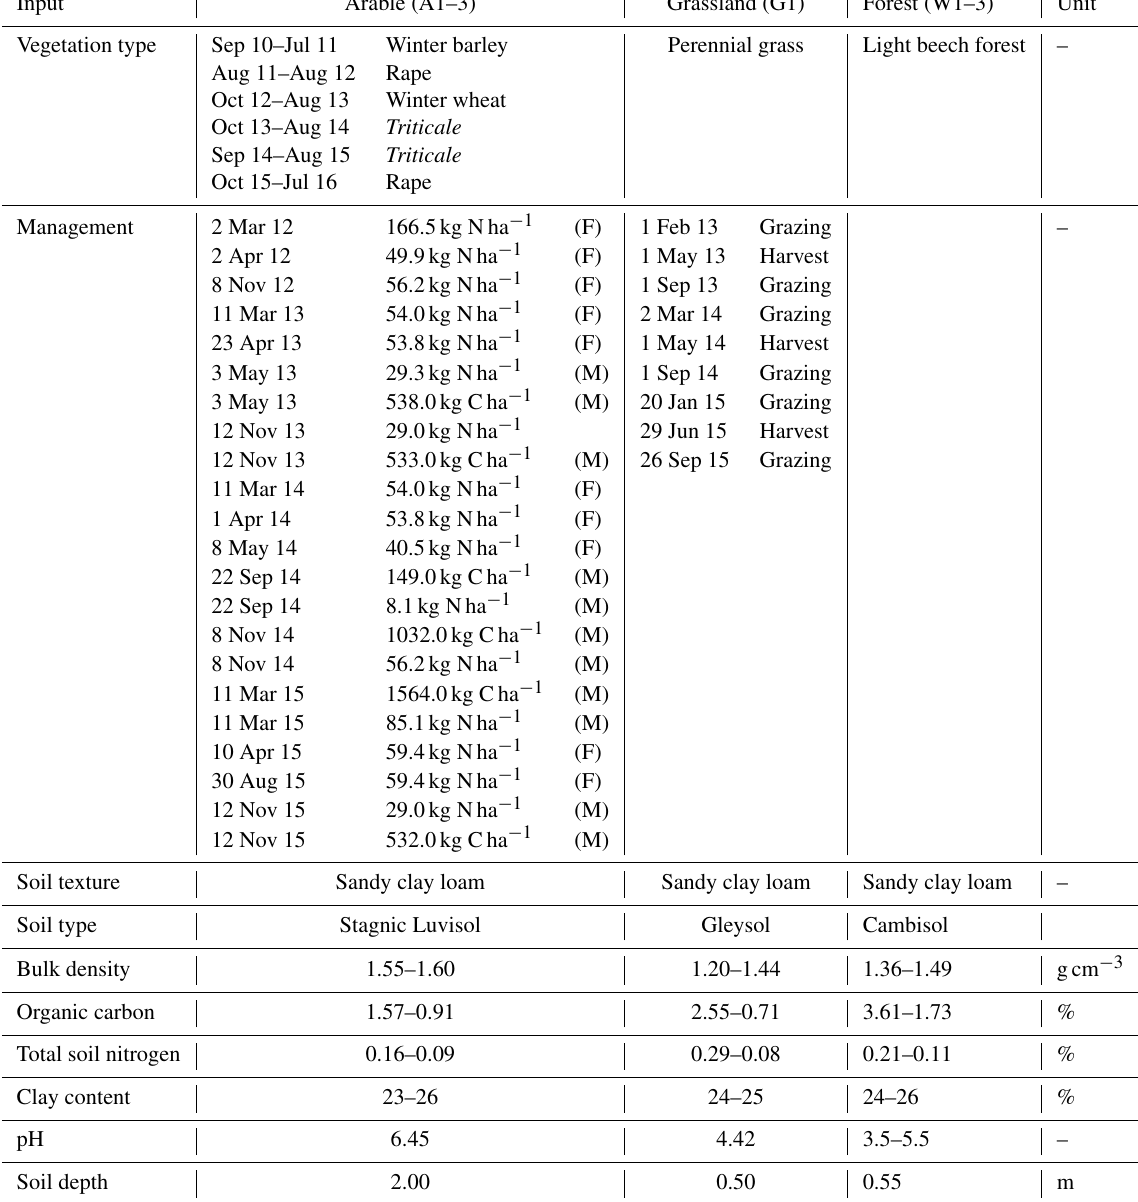
Table 1. Input settings of the LandscapeDNDC model for the three different land uses in the Vollnkirchener study region, based on mea- surements and farmers’ management documentation. When spans are given, they reflect observed ranges for measurements used throughout the set-up of the soil profile, given from the top layer setting to the bottom layer. The soil depth was estimated for model set-up; F, fertilizer application; M, manure